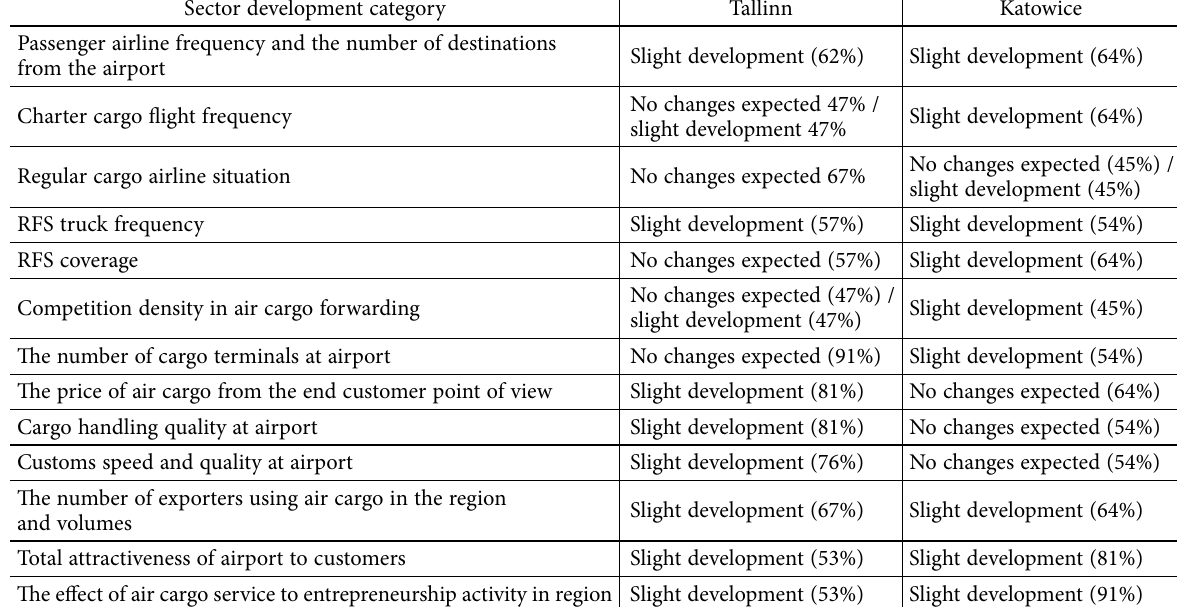
Table 1. Dominant viewpoint of local air cargo sector participants on general air cargo market